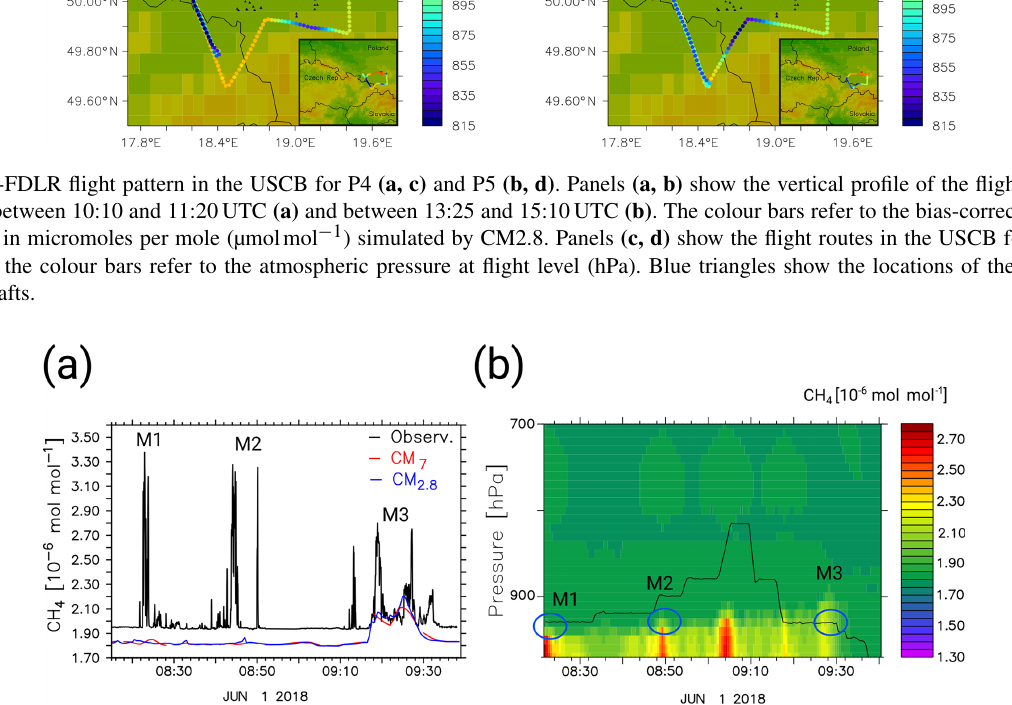
forecast and analysis is reduced faster than the similarity of amplitudes. For S V , the area which exceeds a threshold of 0.7 covers about 65 % and 40 % at forecast days two and three, whereas for S C it only covers about 50 % and 25 %, respectively. From forecast day four onwards, less than 20 % ( S V ) or 10 % ( S C ) of the area reveals a skill larger than 0.7.